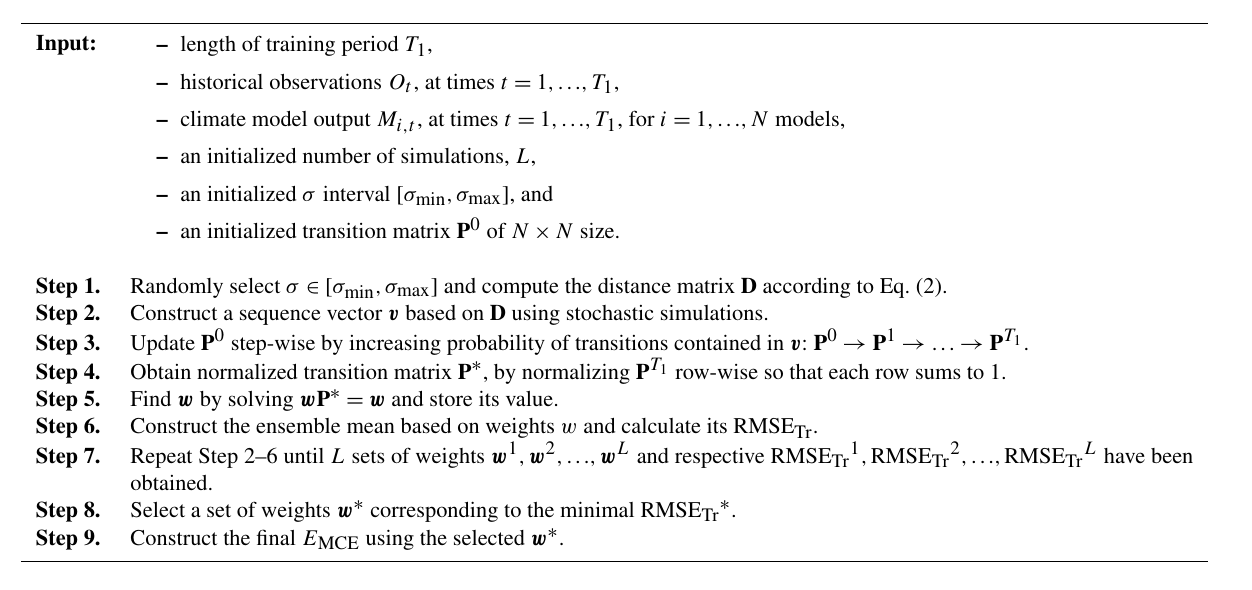
Table 2. The Markov chain ensemble (MCE)